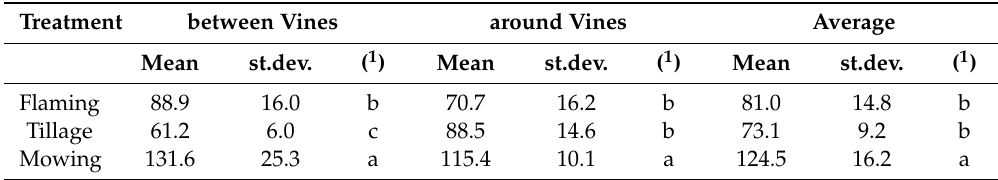
Table 5. Aboveground biomass (g d.m. / m 2 ) on 27